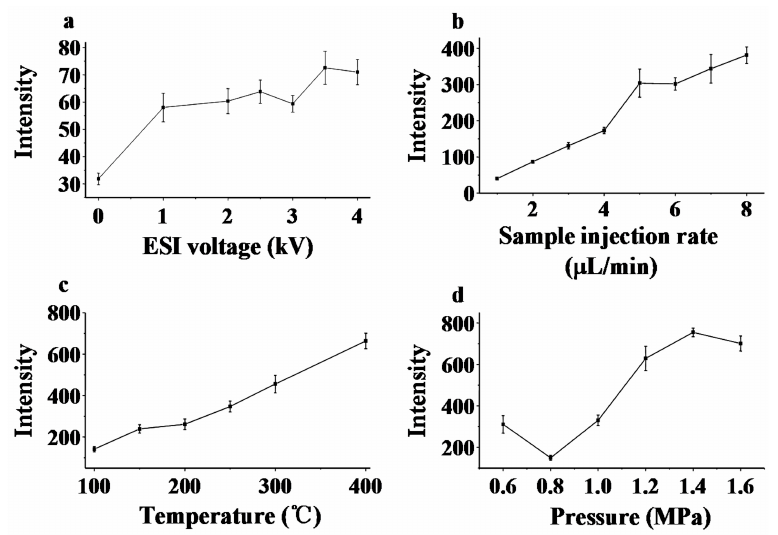
Figure 3. Variation of the signal intensity with the ESI voltage ( a ); sample injection rate ( b ); ion-transport capillary temperature ( c ); and nebulizing gas (N 2 ) pressure ( d ).